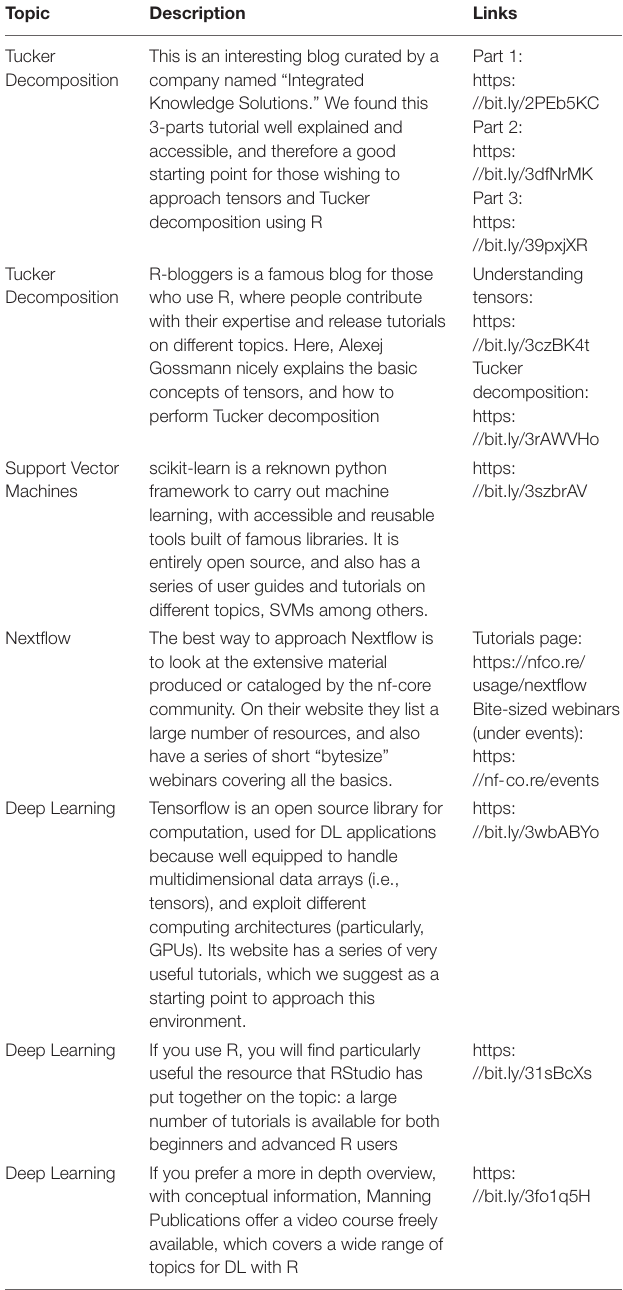
TABLE 3 | Suggested tutorials about bioinformatics methods and tools for omics analyses. Topic